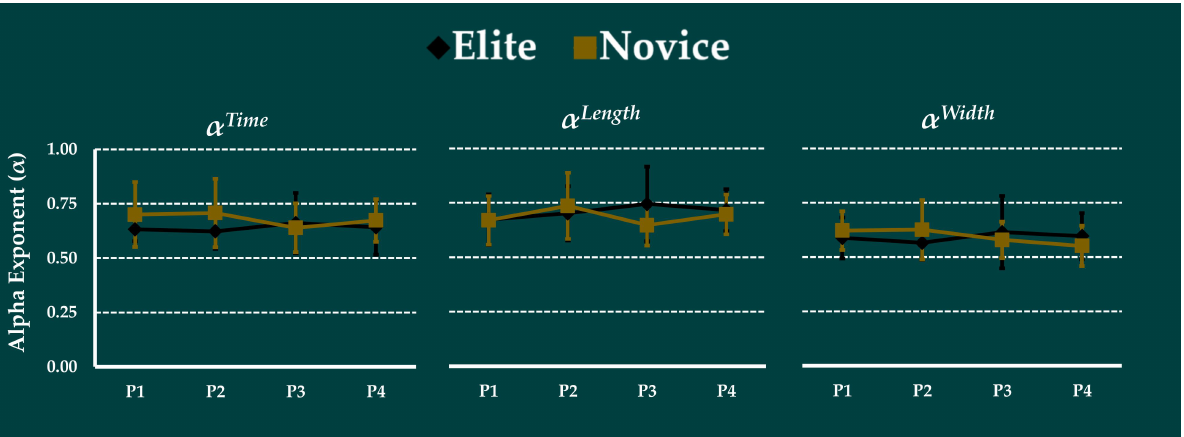
Figure 4. The effect of prolonged run in the alpha exponent of spatiotemporal parameters between novice and elite runners throughout the prolonged run is presented here. Alpha exponent for step- time as α Time , alpha exponent for step-length α Length , and alpha exponent for step-width as α Width . Elite denoted as black diamond, and Novice denoted as khaki square. No significant differences were observed between groups or time-intervals.